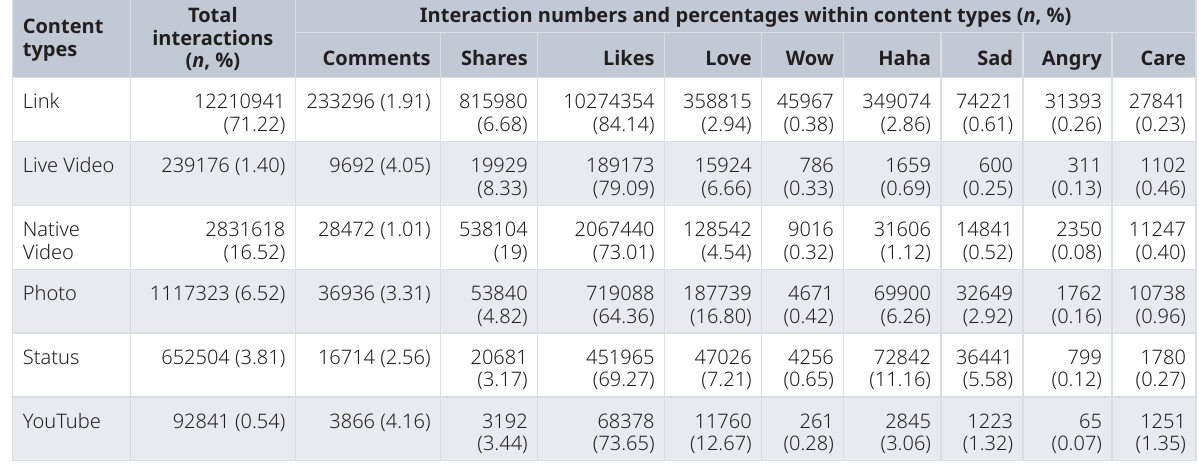
Table 2. Interaction numbers and their percentages within the content types.